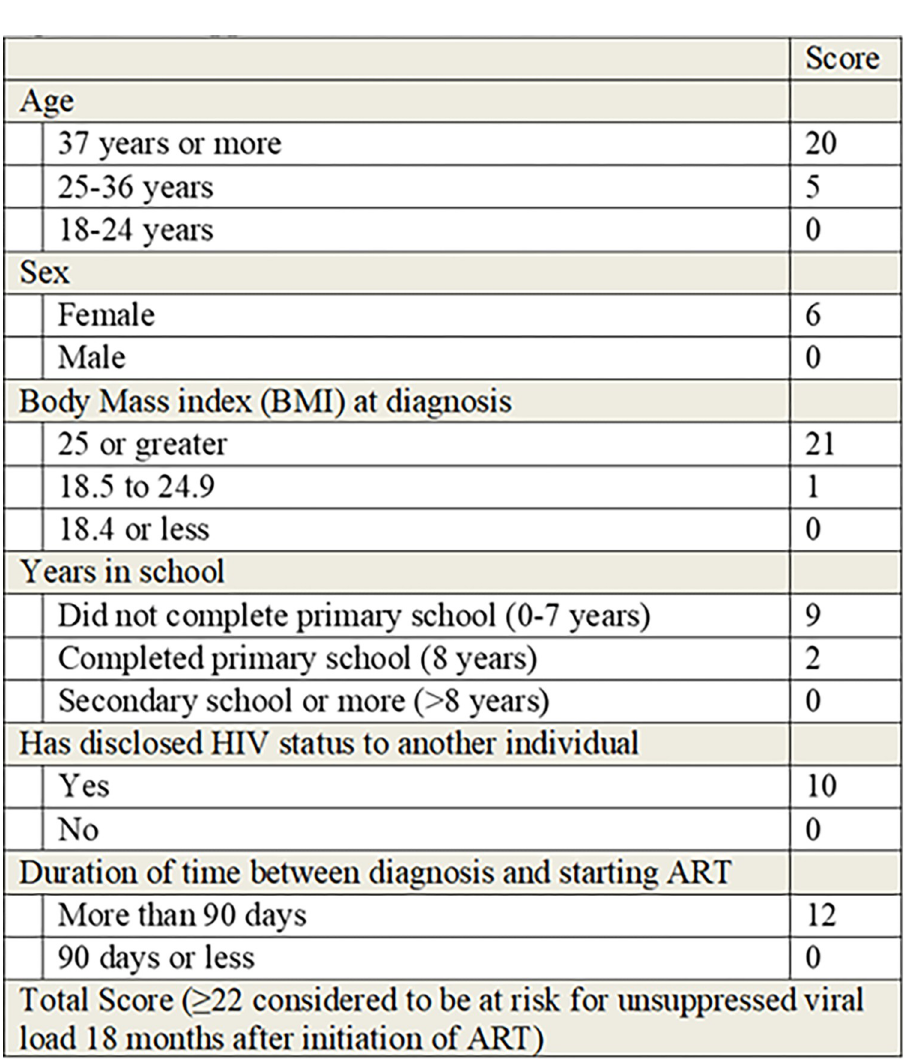
Fig 2. Unsuppressed viral load